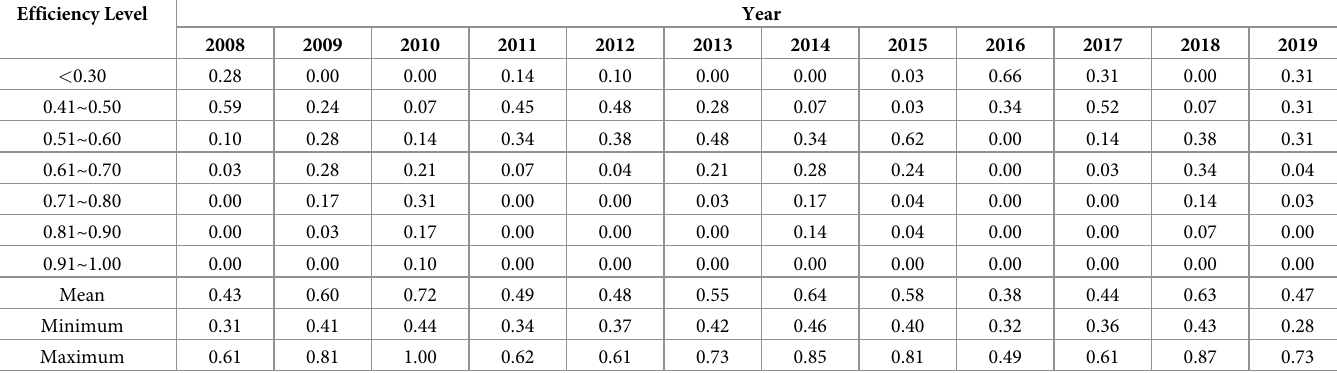
The 29 provinces studied in this paper are divided into the eastern region, central region, west- ern region, and northeast region according to the ’ China Science Statistical Yearbook ’. The eastern region includes nine provinces (cities), namely Tianjin, Hebei, Shanghai, Jiangsu, Zhe- jiang, Fujian, Shandong, Guangdong, and Hainan. The central region consists of six provinces Table 9. Frequency distribution of cost efficiency estimates for piglets, 2008–19. Efficiency